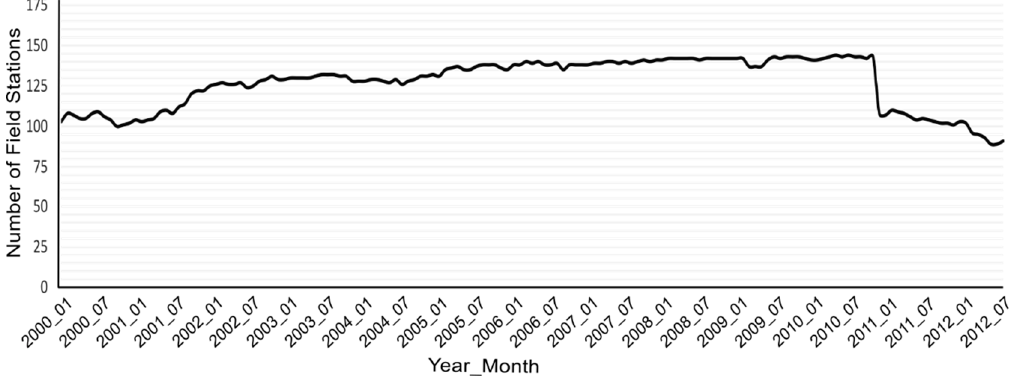
Figure 6. Number of ground-truth stations available per month for validation.